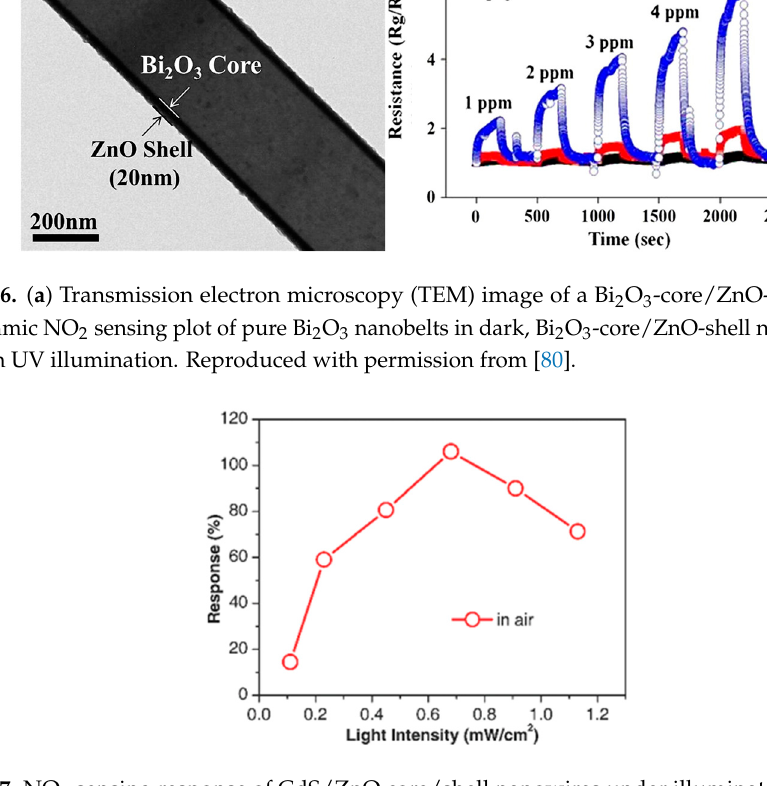
Figure 57. NO 2 sensing response of CdS/ZnO core/shell nanowires under illumination of different light intensity. Reproduced with permission from [41].